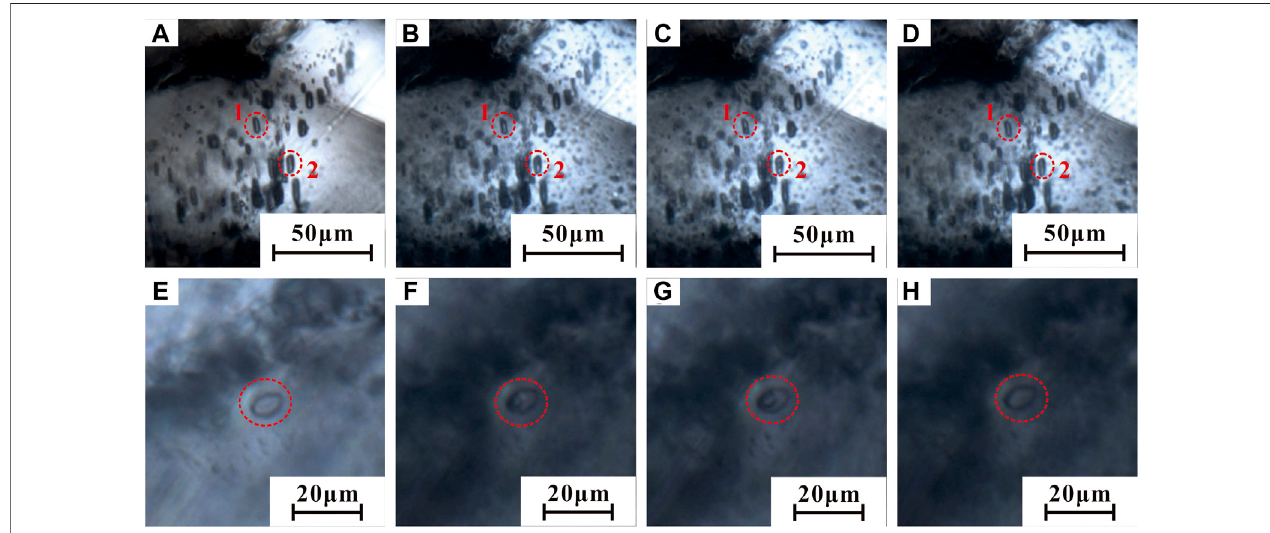
FIGURE 8 | Low temperature phase transformation of methane inclusions of sample N228-3479.4 m. (A – D) Micrographs of methane inclusions at 20 ° C, − 104.5 ° C, 180.9 ° C, and − 93.7 ° C, and the Th of number 1 methane inclusion is − 94.6 ° C, while that ofnumber 2 is − 93.7 ° C; (E – H) Micrographs ofmethane inclusions at